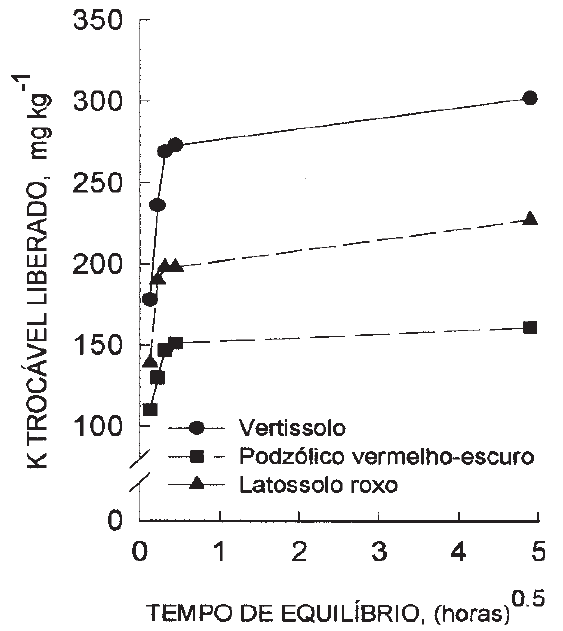
Figura 1. Liberação cumulativa de K trocável dos solos em função do tempo de equilíbrio com a